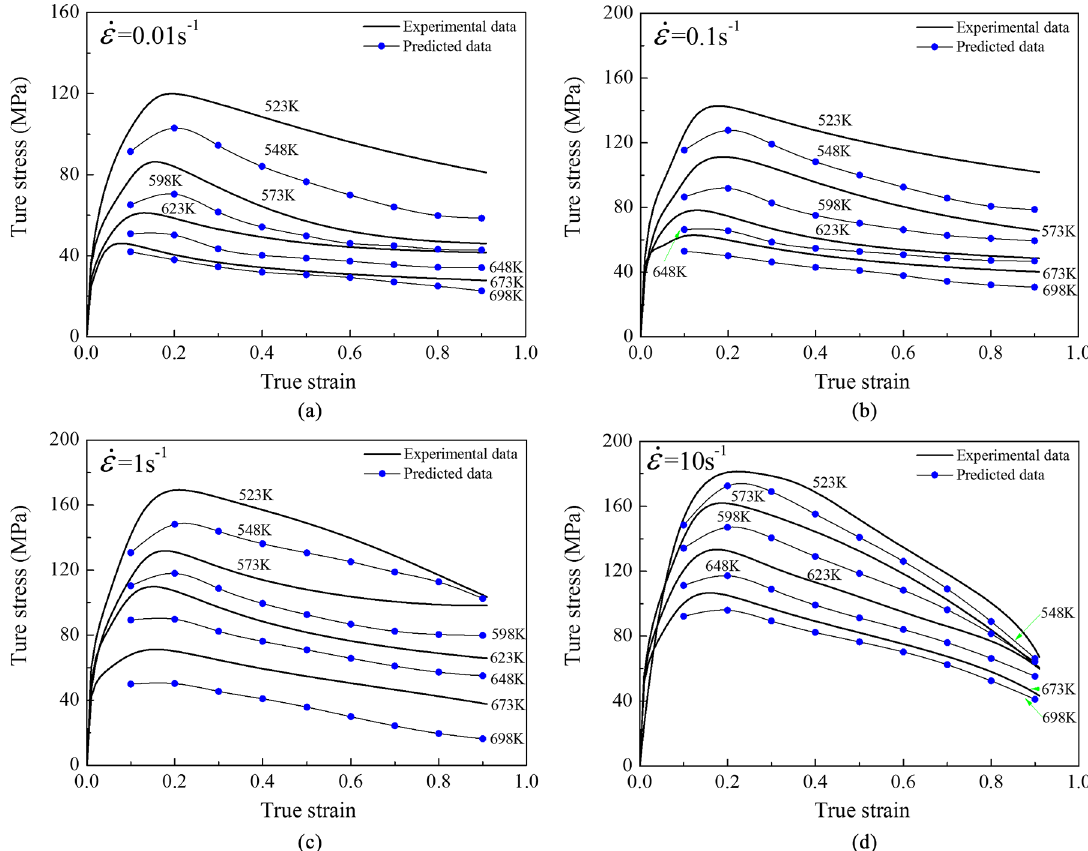
Figure 9. The true stress-strain data of AZ80 magnesium alloy under different temperatures and different strain rates (a) 0.01 s –1 , (b) 0.1 s –1 , (c) 1 s –1 , (d) 10 s –1 , among which the solid curves are experimental data and the fitted curves by dots are predicted